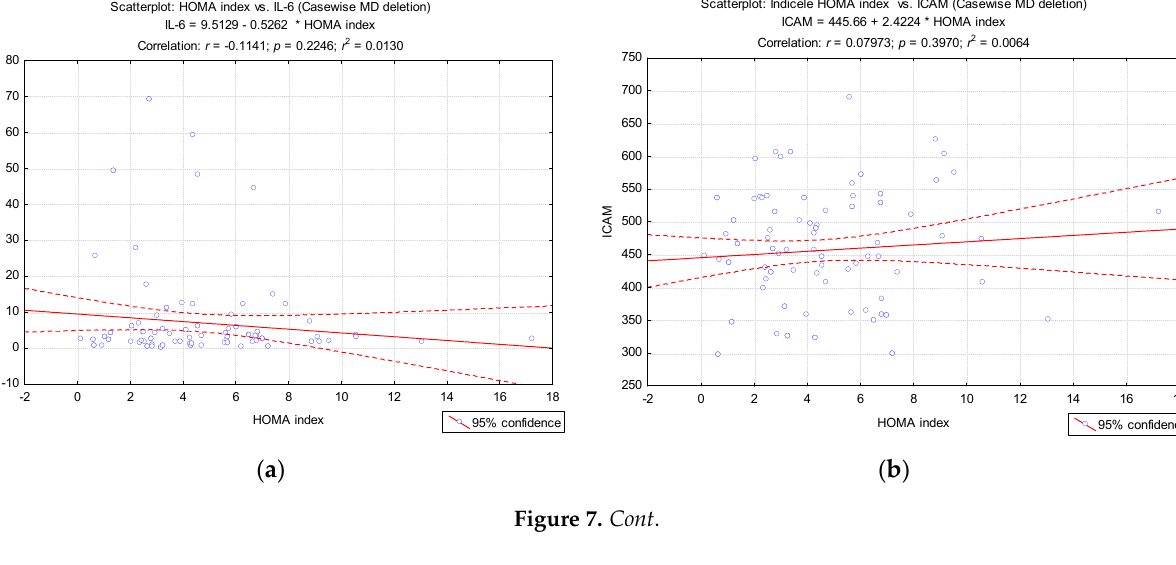
Scatterplot: HOMA index vs. IL-6 (Casewise MD deletion)